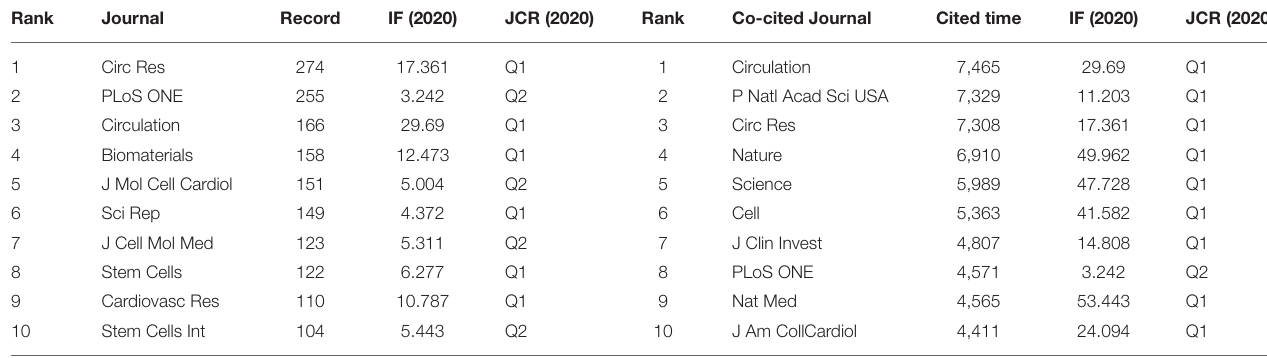
TABLE 3 | The top 10 productive and co-cited journals.